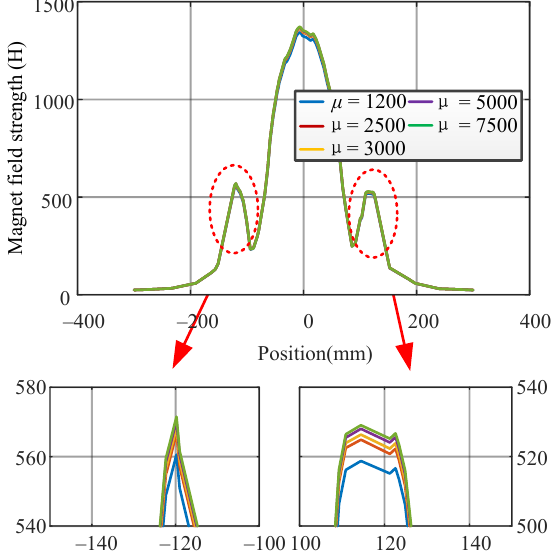
Figure 15. Magnetic field strength curves of shields of MnZn with different relative permeabilities.